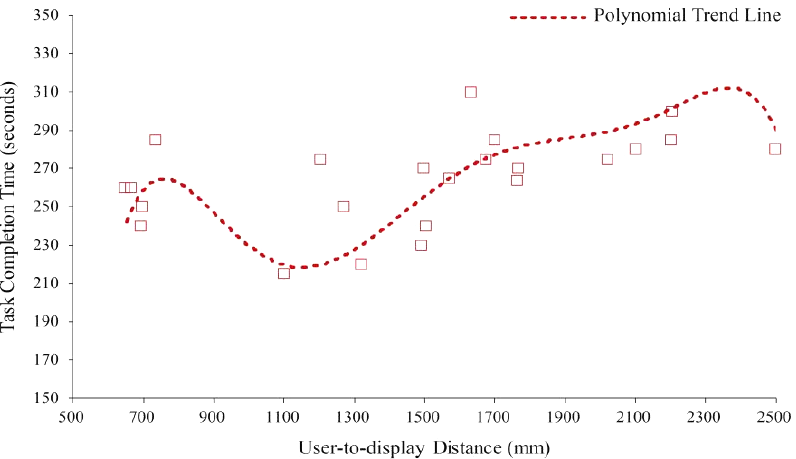
Figure 5. Correlation between the participants ’ interaction distance and the task completion time.